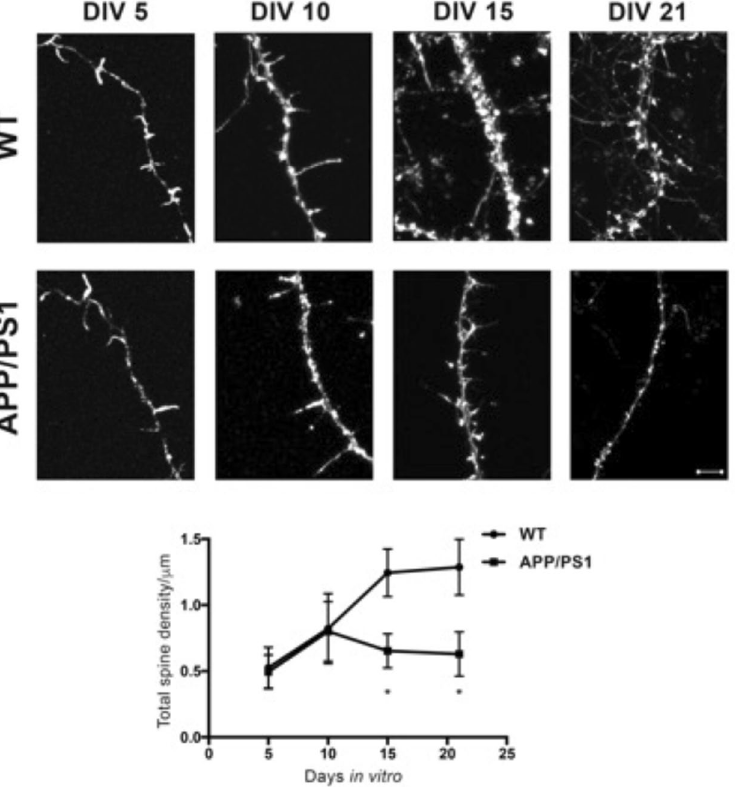
Figure 1. Representative confocal images of dendritic spines of neurons from WT and APP/PS1 mice at DIV (days in-vitro )-5, DIV-10, DIV-15 and DIV-21. Scale bar is 5 μ m. Top - Quantification for total spine density at DIV-5, 10, 15 and 21. Bottom - Total spine density of wild-type (WT) and APP/PS1 groups is similar at DIV-5 and 10. Significant spine loss is observed at DIV-15 and is sustained till DIV-21. Data is represented as Mean + SEM (n = 30 neurites per group) and statistical significance: * p < 0.0001 for WT versus APP/PS1 (Two- way RM ANOVA followed by Bonferroni post-hoc test).